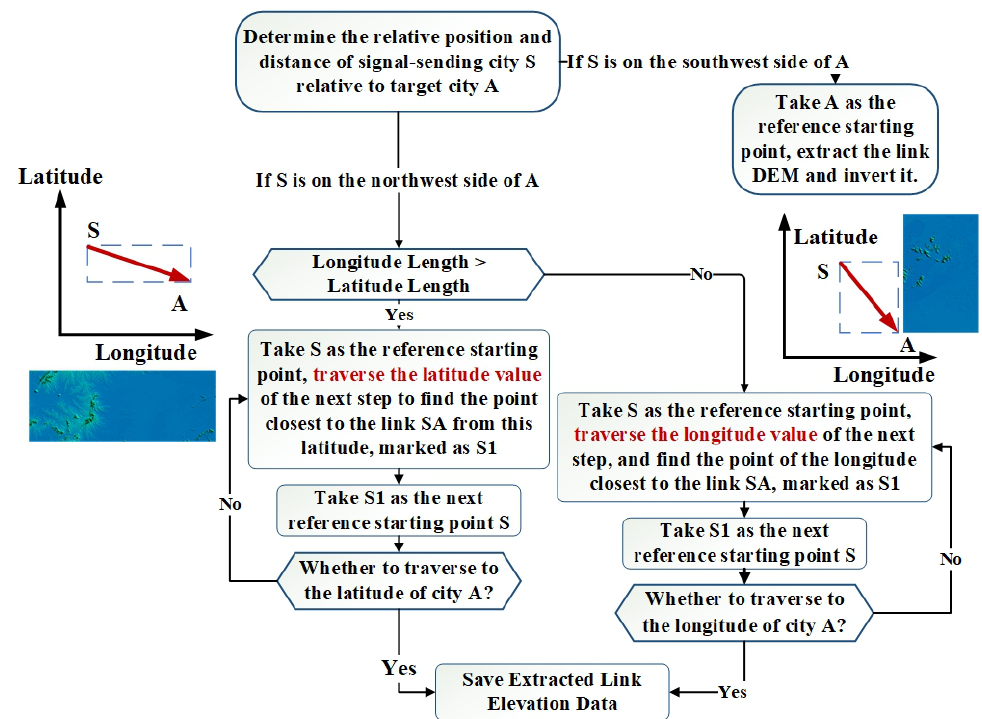
Figure 6. DEM of the selected area.